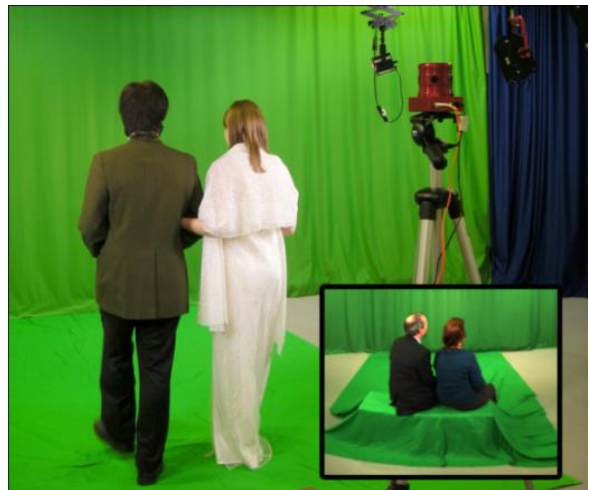
Figure 17 Recording actors with Ladybug 2 camera in a green screen studio.